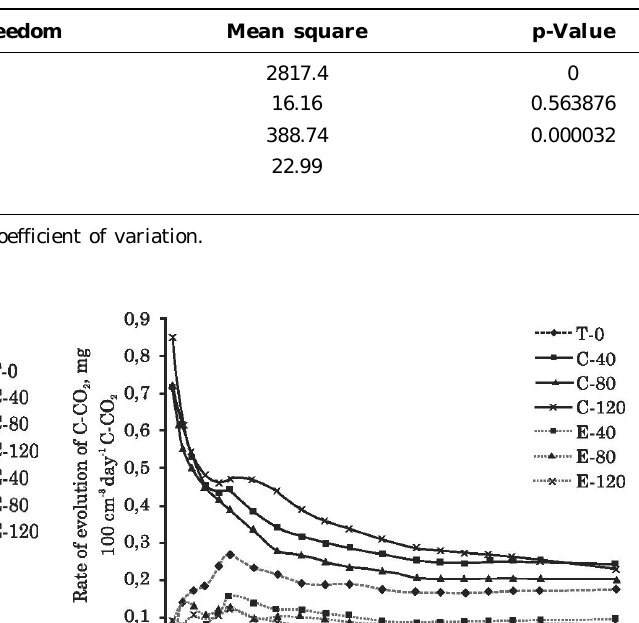
Table 5. Analysis of variance of C-CO 2 emission from waste material treated with limestone or steel slag, accumulated in 262 days